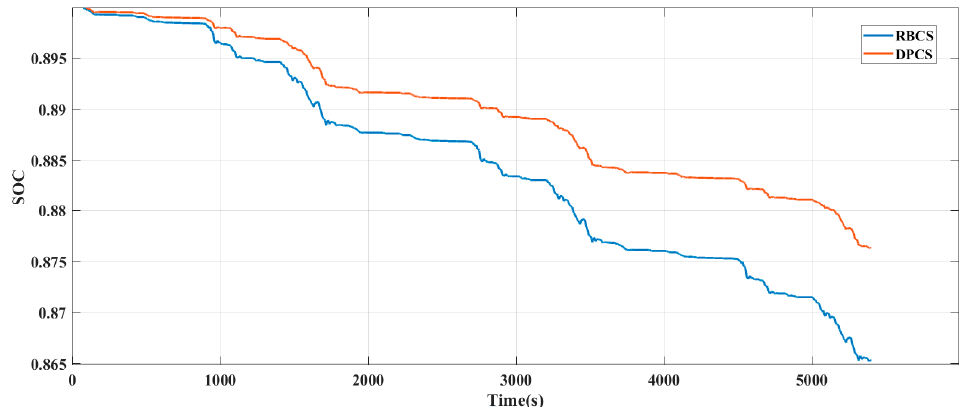
Figure 9. SOC curve of a typical city in China under different control strategies.